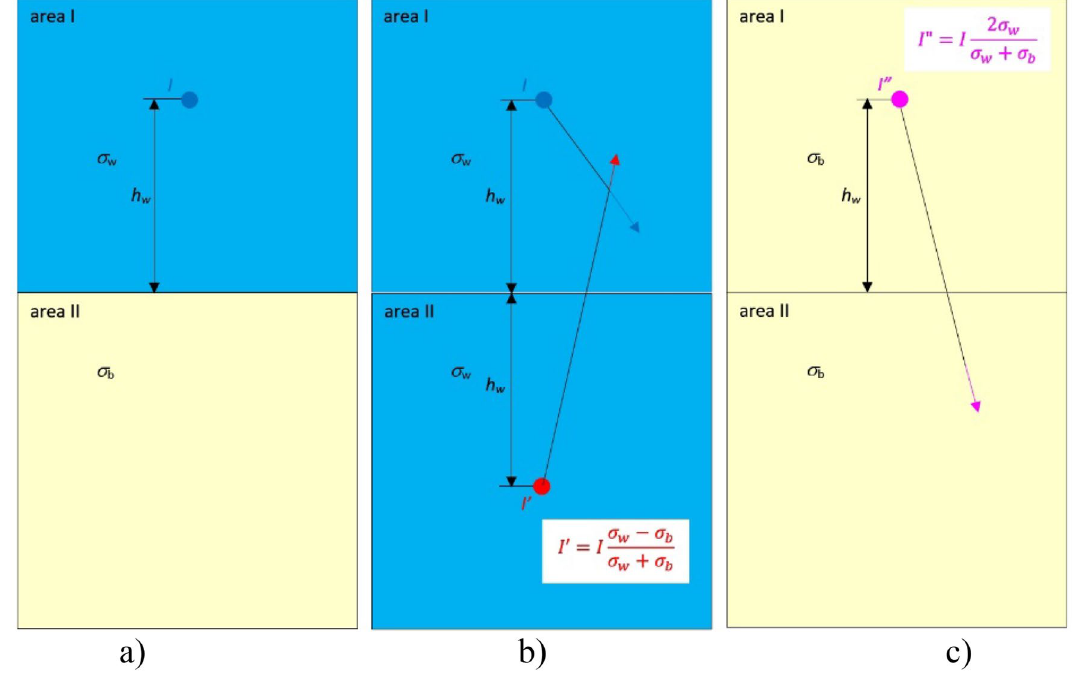
Figure 3. Method of electric field calculation in two layers with different electric